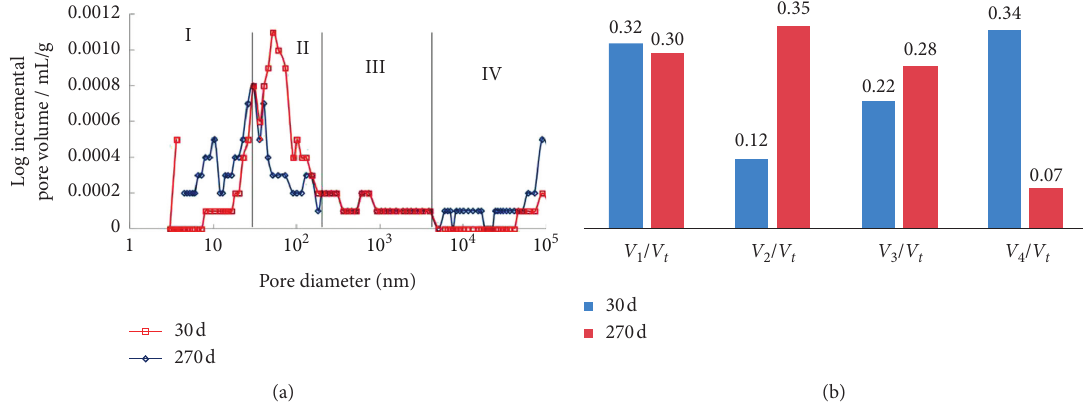
(nm)1 Pore diameter